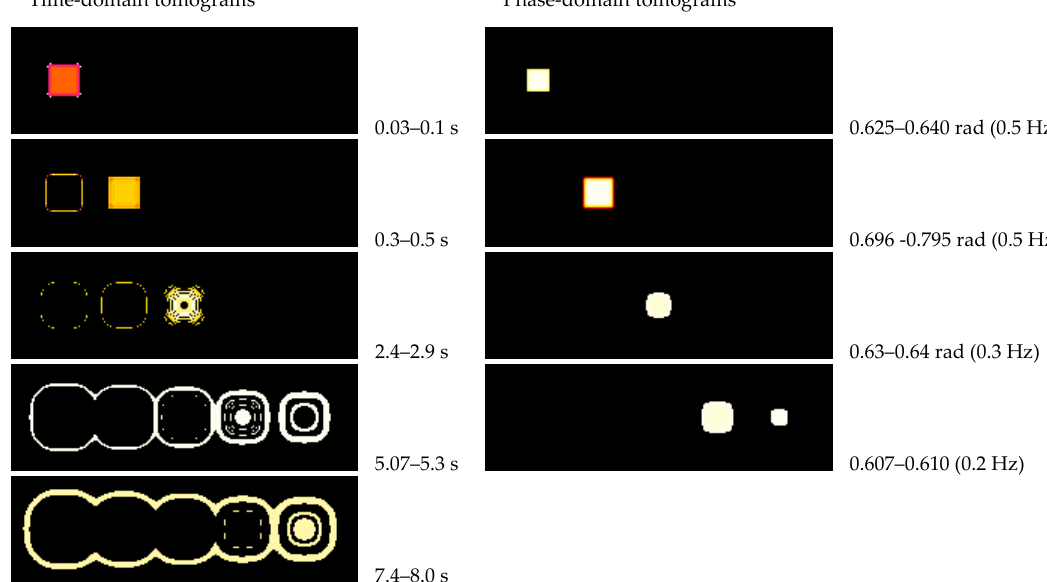
Figure 3. Comparison between time- and phase-domain approaches to thermal tomography.